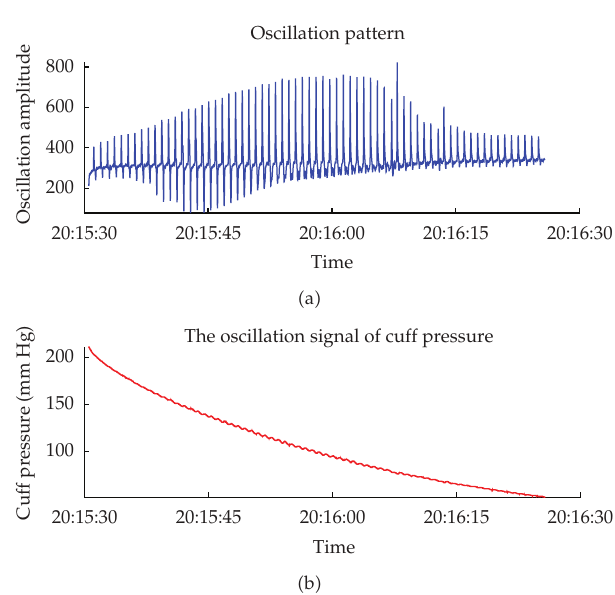
Figure 1: Oscillation pattern extracted from the cu ff pressure with the oscillometric